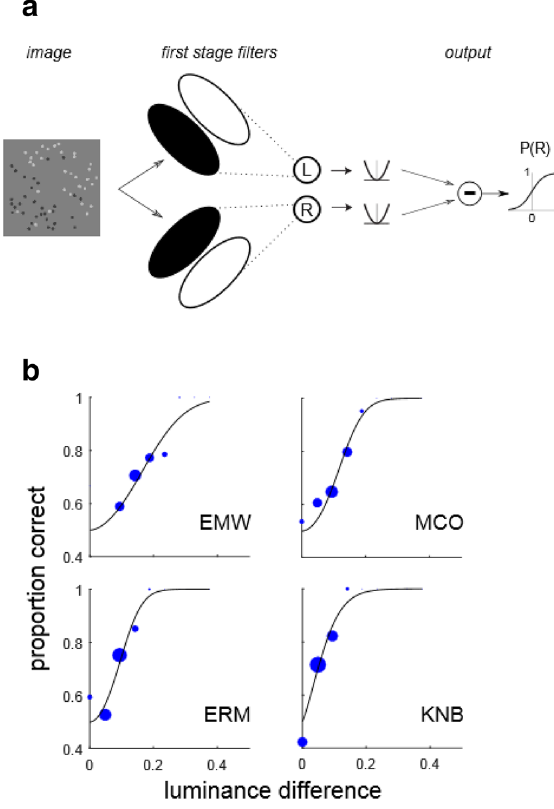
Figure 4. Single-stage filter model. ( a ) Image-computable model with a single stage of filtering (IC-1). Luminance differences are computed across the left-oblique and right-oblique diagonals, passed through a rectifying, exponentiating nonlinearity and subtracted to determine the probability P(R) of observer classifying the boundary as right-oblique. In the case where there is only a luminance difference across one diagonal, this model is equivalent to the IC-SDT model (Eq. (4)). ( b ) Fits of the model in (a) to LTB segmentation data from Experiment 1a for the same observers as in Fig.